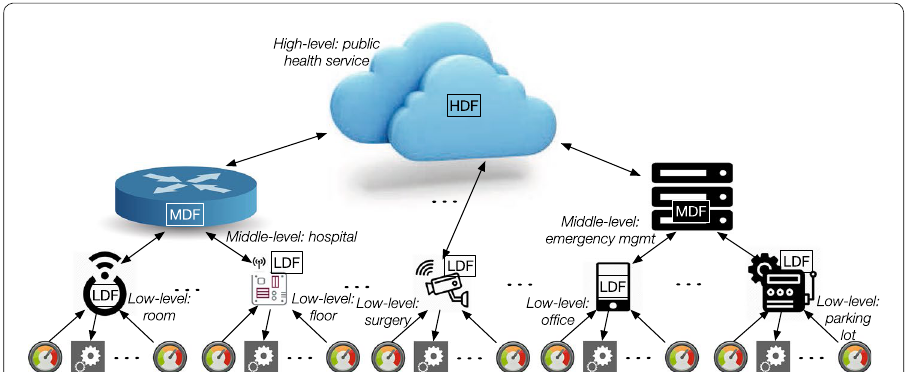
Fig. 1 Overview of a multi-level hierarchical data fusion on a Smart Healthcare scenario. This figure illustrates the proposed approach at a high level. It shows what elements constitute each of the levels of the data fusion